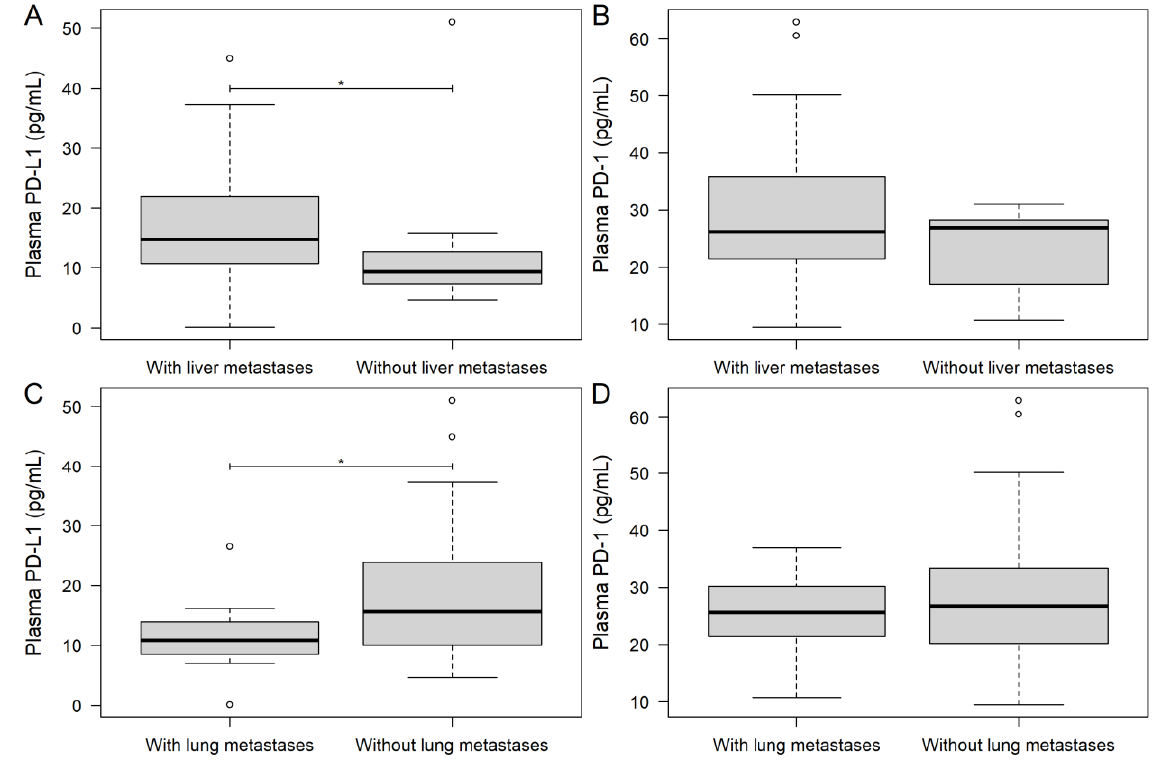
Figure 2. Baseline PD-1 and PD-L1 measurements of study participants grouped by the presence of hepatic ( A , B ) and lung ( C , D ) metastases. Thick lines and hollow circles represent medians and outliers, respectively. PD-1: plasma programmed cell death protein 1; PD-L1: programmed death-ligand 1. * p < 0.05. With hepatic metastases: n = 26; without hepatic metastases: n = 11; with lung metastases: n = 13; without lung metastases: n = 24.